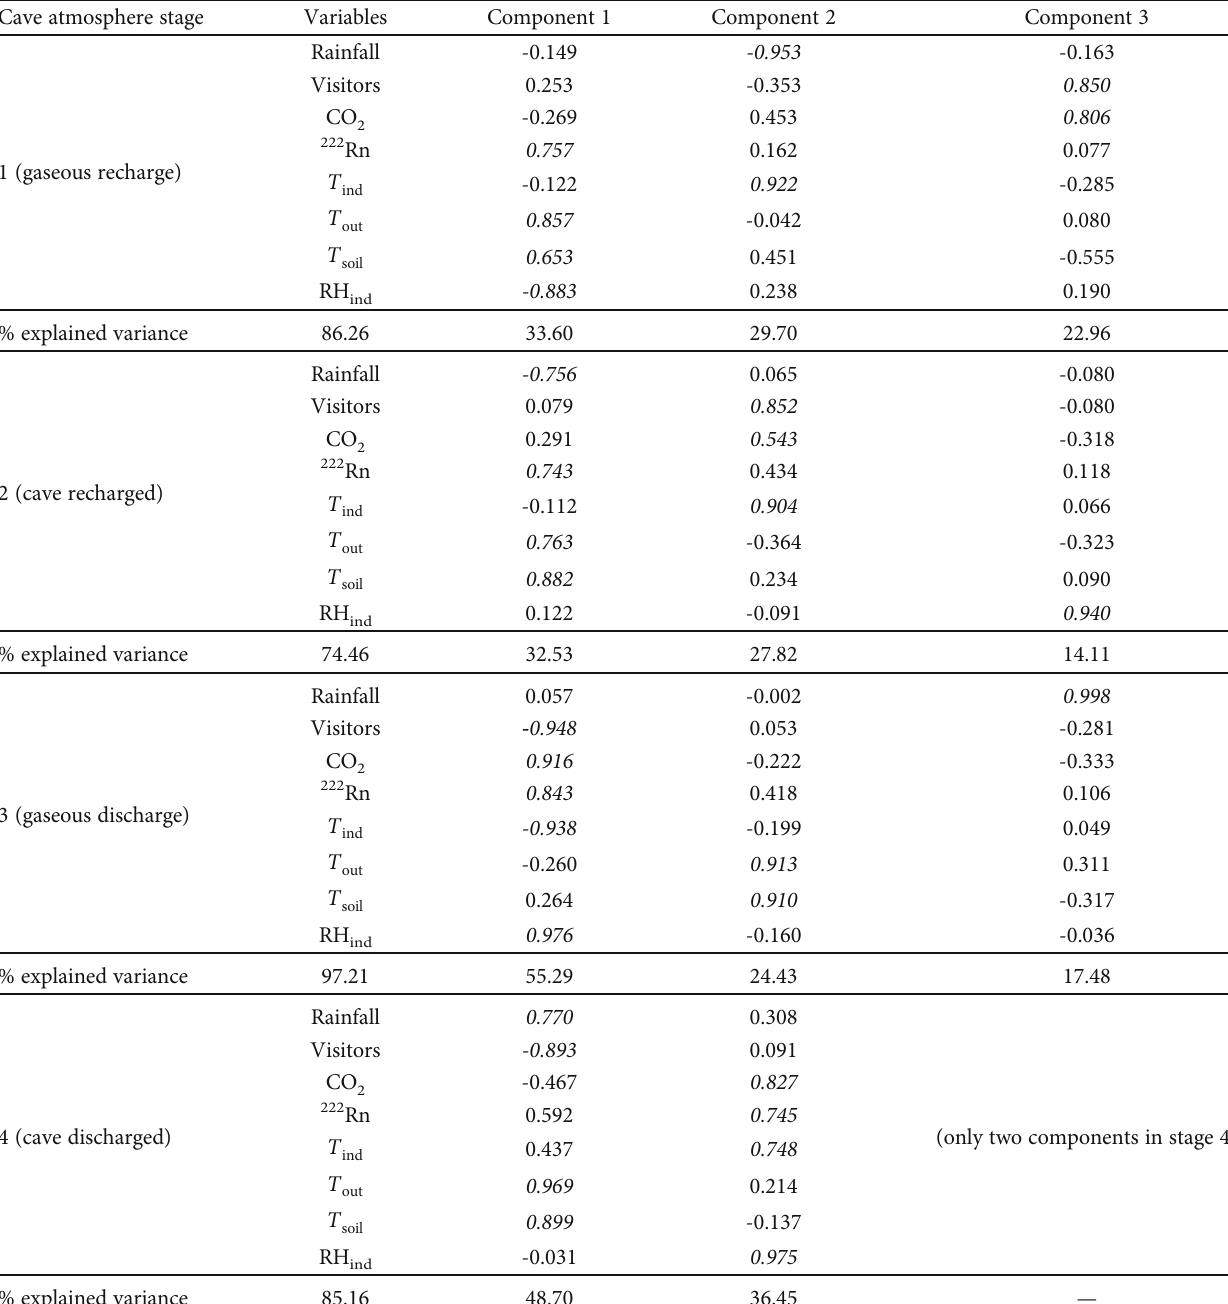
Table 1: Results of variable grouping from PCA considering the di ff erent stages that Rull Cave